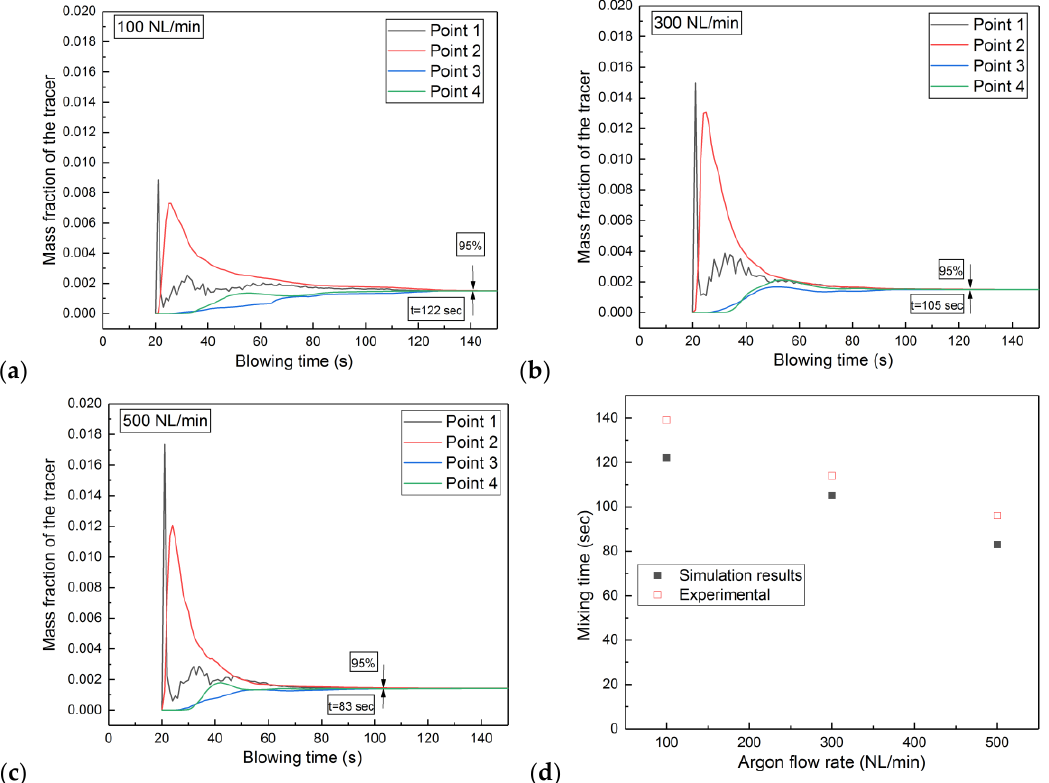
Figure 10. Tracer concentration change for different gas flow rates of ( a ) 100 NL/min ( b ) 300 NL/min and ( c ) 500 NL/min. ( d ) Comparison of simulated average mixing time for different gas flow rate with the experimental values.